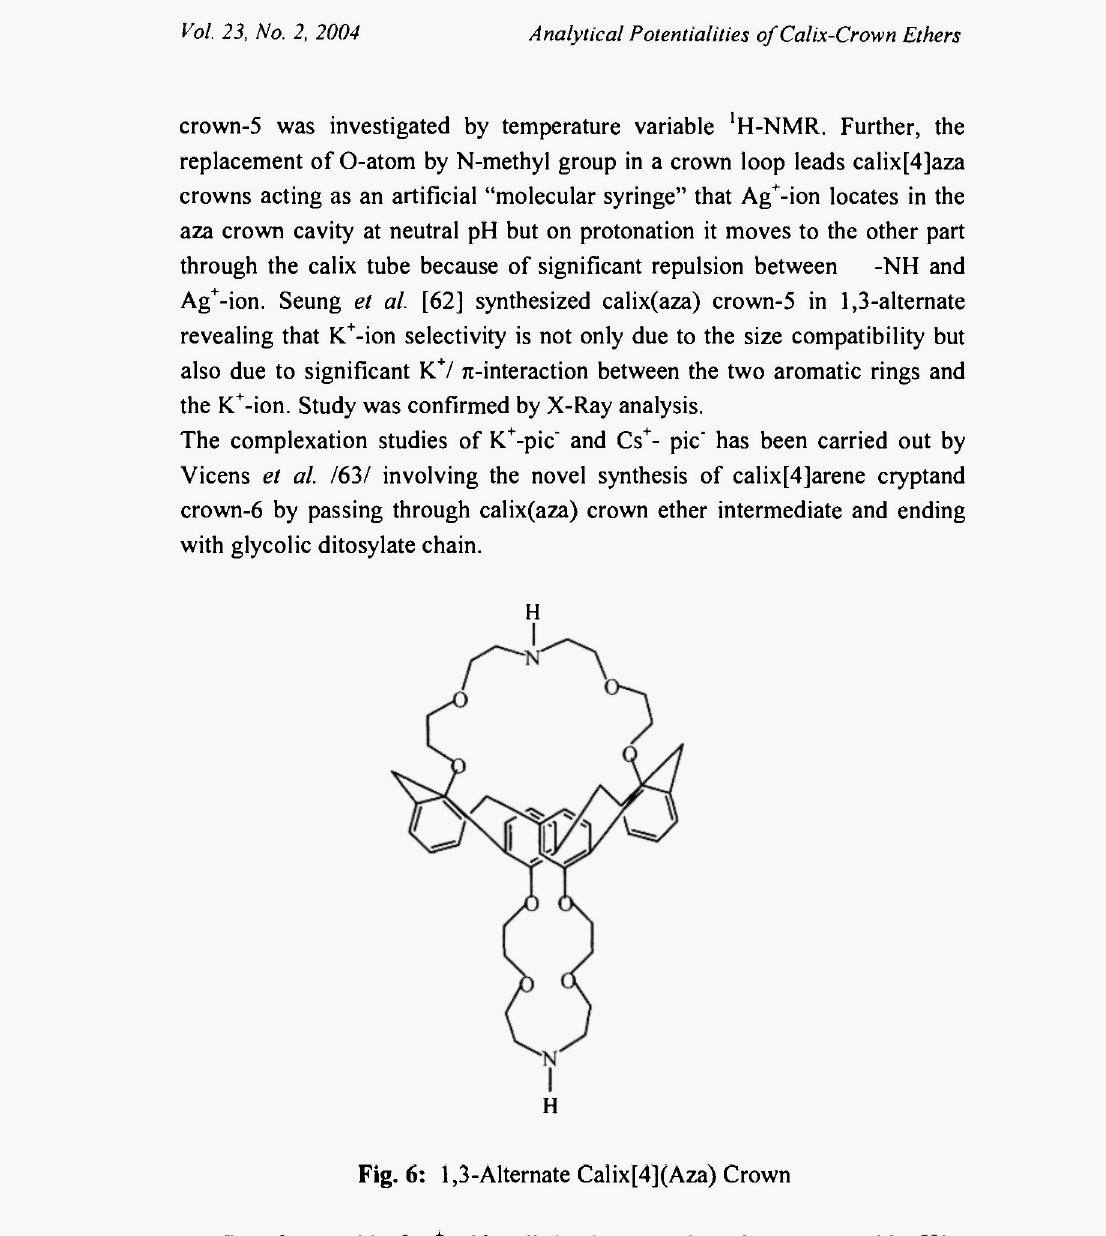
Fig. 6: 1,3-Alternate Calix[4](Aza)